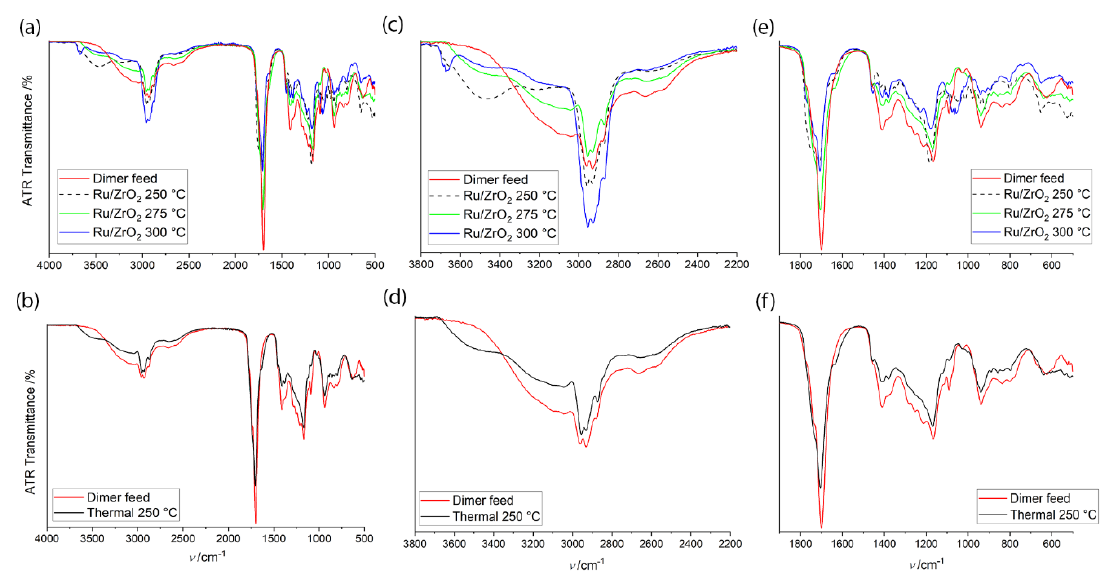
Figure 8. Attenuated total reflection (ATR) IR spectra of the feed and the samples obtained with ( a ) Ru catalyst in different temperatures and ( b ) thermally at 250 °C. ( c , d ) O – H and sp 3 C – H stretching range, ( e , f ) C=O stretching range and the fingerprint region.